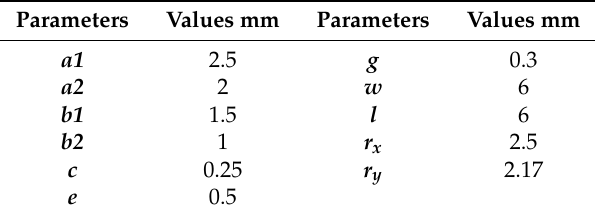
Table 1. Design parameters of the unit cell.